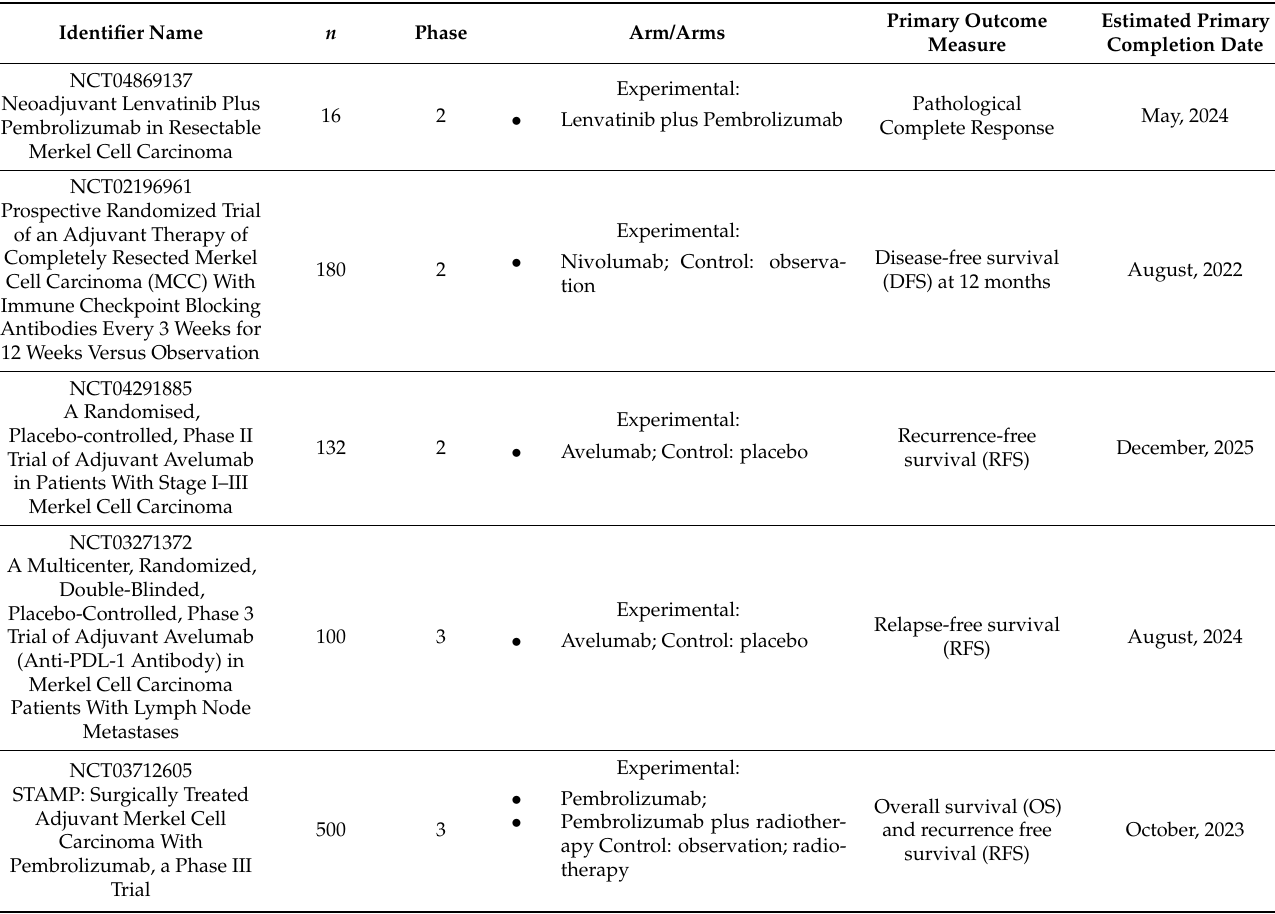
Table 2. Ongoing clinical studies of interest enrolling patients with non-metastatic Merkel cell carcinoma (source: clinicaltrials.gov; last accessed: 30 July